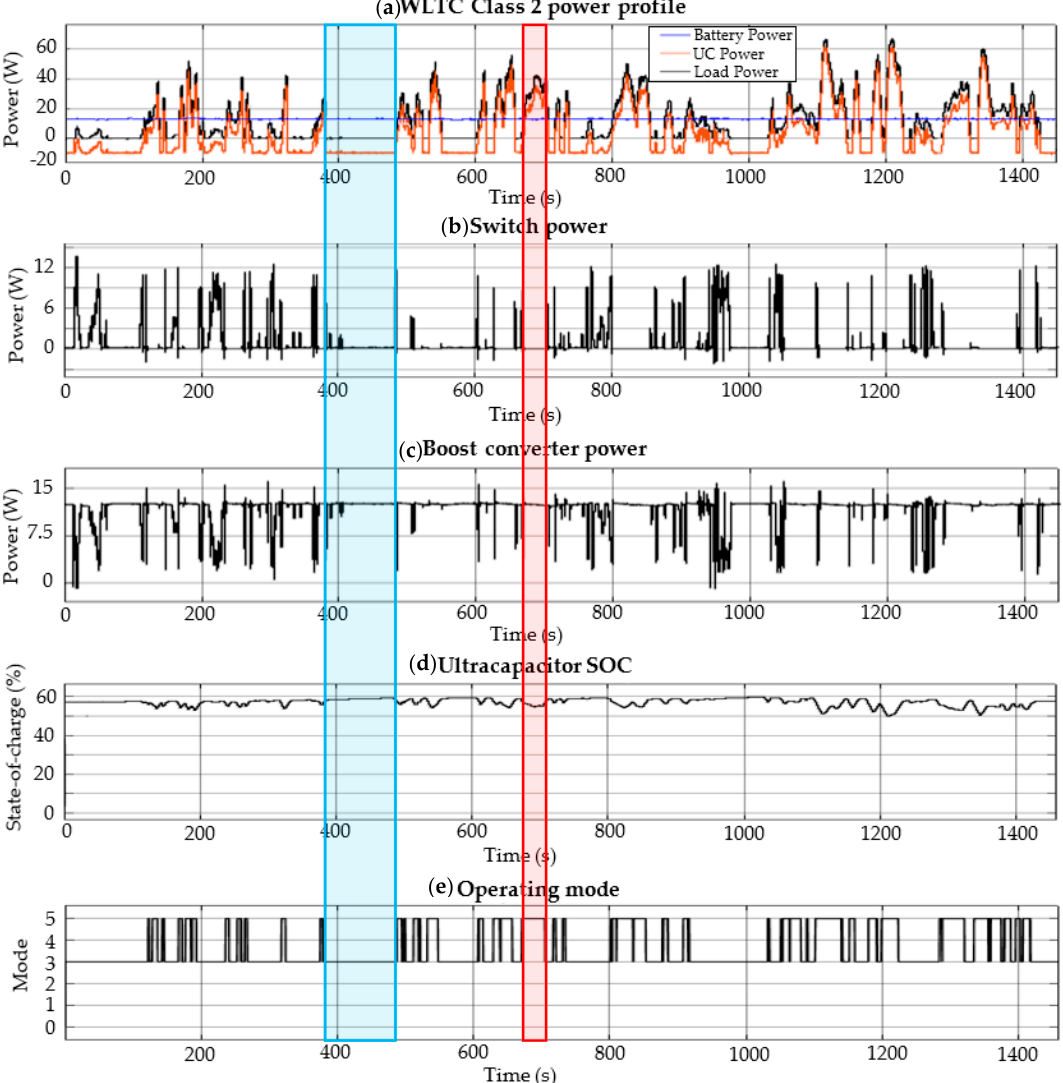
Figure 16. ( a ) WLTC Class 2 power distribution; ( b ) Power through the switch; ( c ) Power transferred through the boost converter; ( d ) UC state-of-charge; ( e ) Controller operating mode.